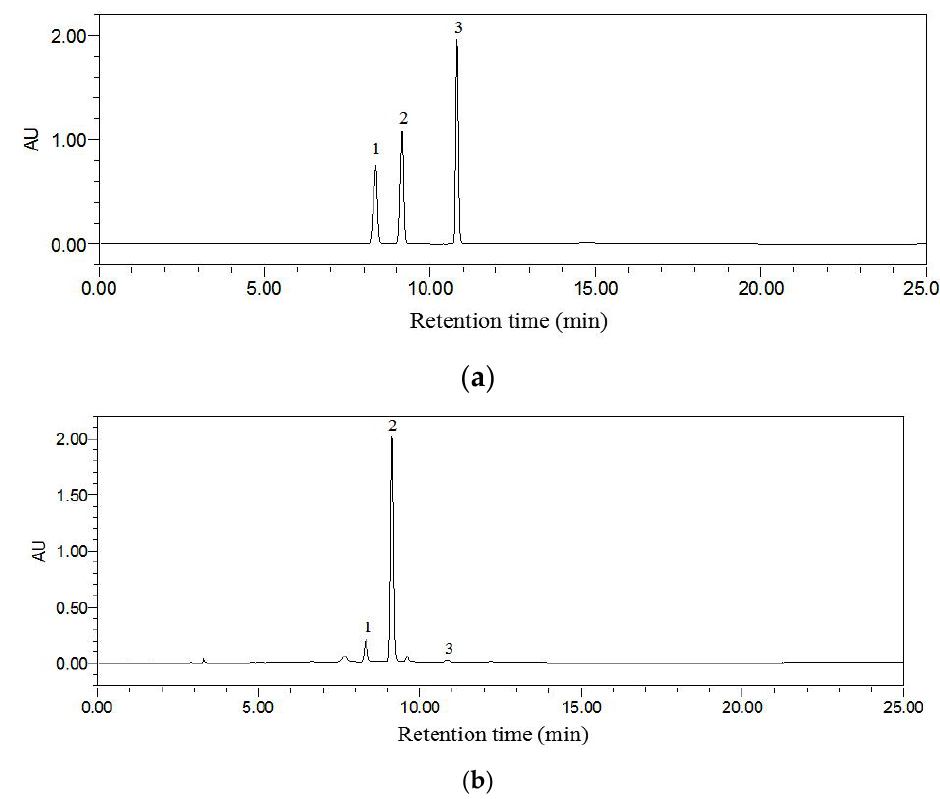
Figure 5. The high-performance liquid chromatography with diode array detection (HPLC-DAD)